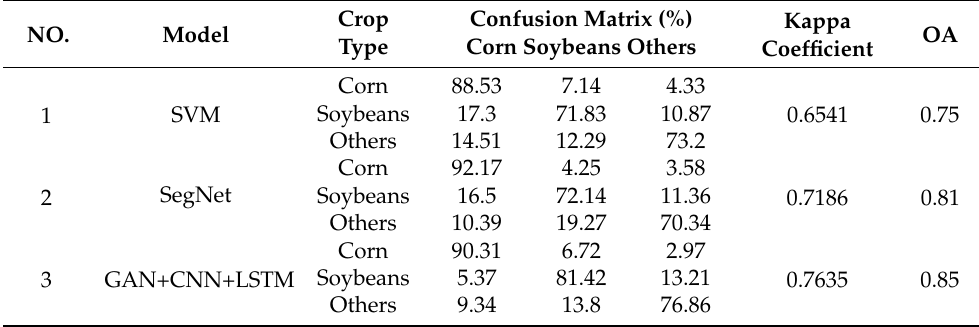
Table 3. Quantitative evaluation of the model’s prediction results in Fayette County.